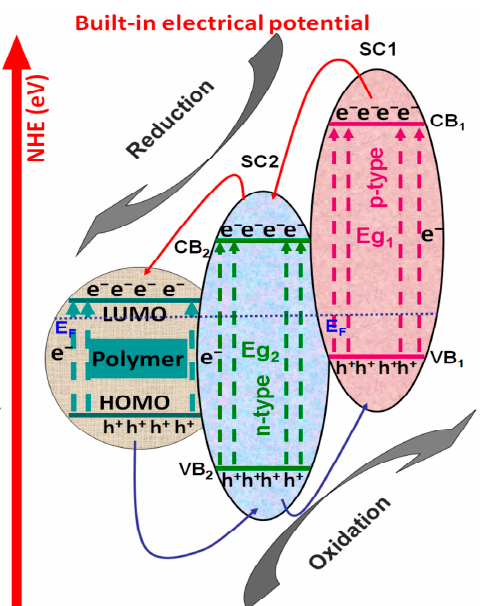
Figure 4. Photocatalytic composite based on polymer/tandem materials.